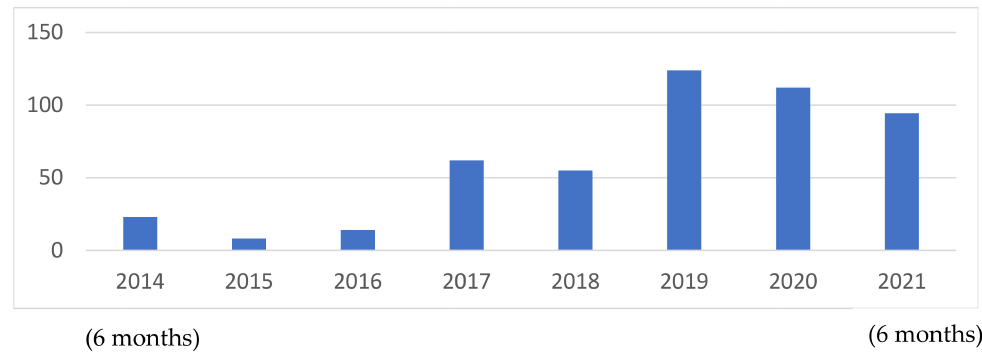
Figure 6. Number of patients tested per year over the seven years of